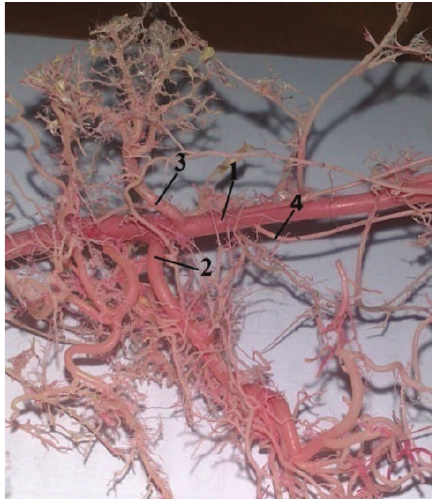
Figure 10: Photograph pointing out the origin of the a. mesenterica cranial is cranial to the a. renalis dextra . 1: aorta abdominalis , 2: a. mesenterica cranialis , 3: a. renalis dextra , and 4: a. testicularis dextra (casting medium Duracryl Dental).